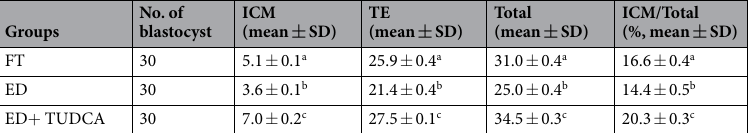
Table 3. Effect of TUDCA supplementation during embryo culture on the quality of blastocysts. Note: Different letters within the same column indicate statistical differences at p < 0.05 by one-way ANOVA followed by the LSD multiple comparison test (N = 3). FT: blastocysts developed from conventional freeze-thaw boar spermatozoa without TUDCA-treatment; ED and ED + TUDCA: blastocysts developed from evaporatively dried boar spermatozoa with 0 and 200 μ M TUDCA-treatment, respectively. ICM: cell numbers of the inner cell mass; TE: numbers of trophoblast cells; Total: cell numbers of the inner cell mass plus numbers of trophoblast